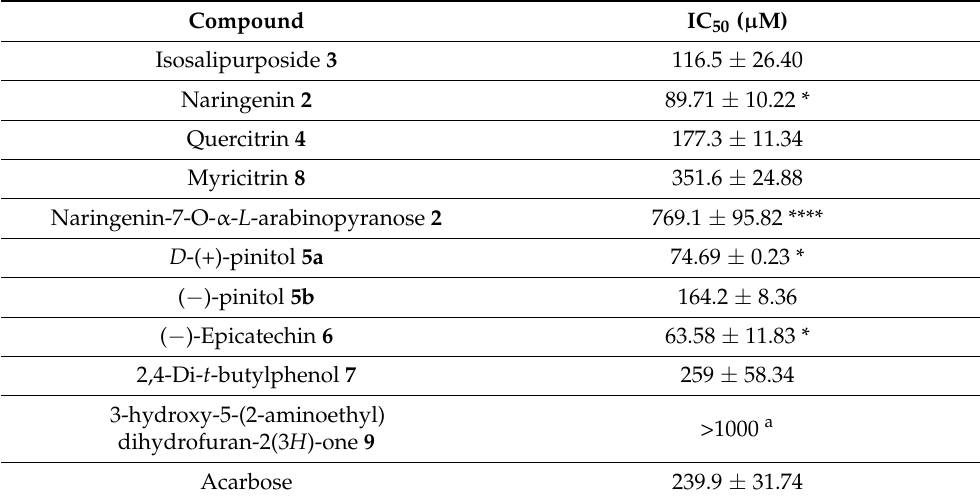
Table 7. Inhibitory activity of the isolated compounds against yeast α